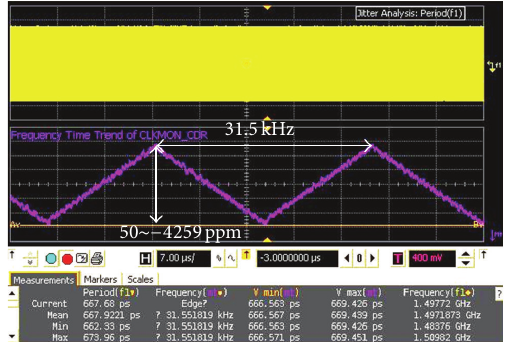
Figure 20: Measurement result of the output signal frequency modulated by triangular signal. Modulation frequency is 31.5 kHz and modulation deviation is from +50 ∼− 4259 ppm at 1.5